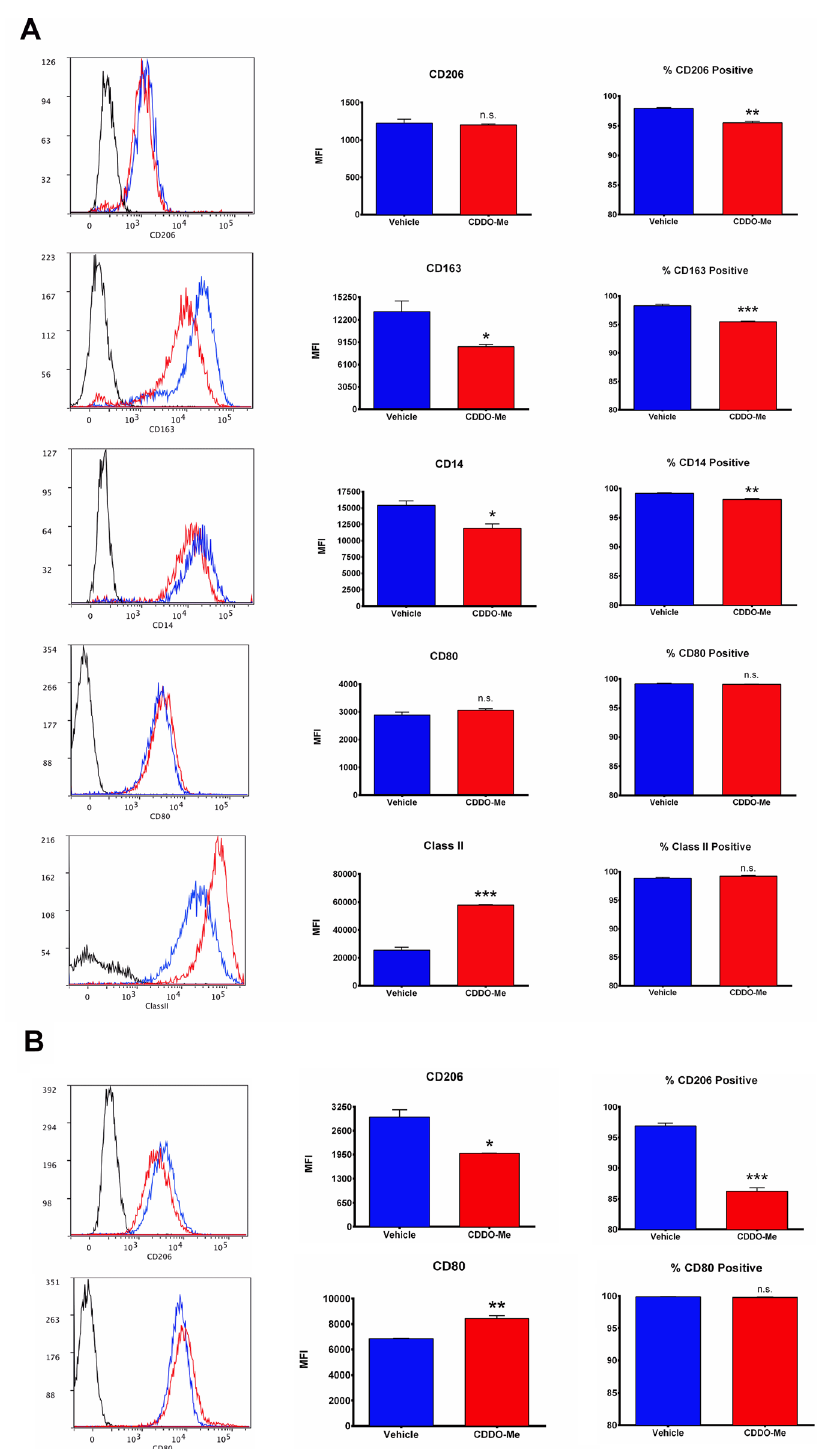
Fig 2. CDDO-Me up-regulates surface expression of M1-characteristic markers and attenuates expression of M2 markers. Human M2-polarized macrophages were treated with 300 nM CDDO-Me or DMSO control for 16 hrs (A) without or (B) with stimulation with LPS for 24 hrs. Expression levels of surface markers were quantified using flow cytometric analysis and are presented in mean fluorescence intensity (MFI) units. Gating of positively stained cells was determined by FMO controls (black histograms). * p <